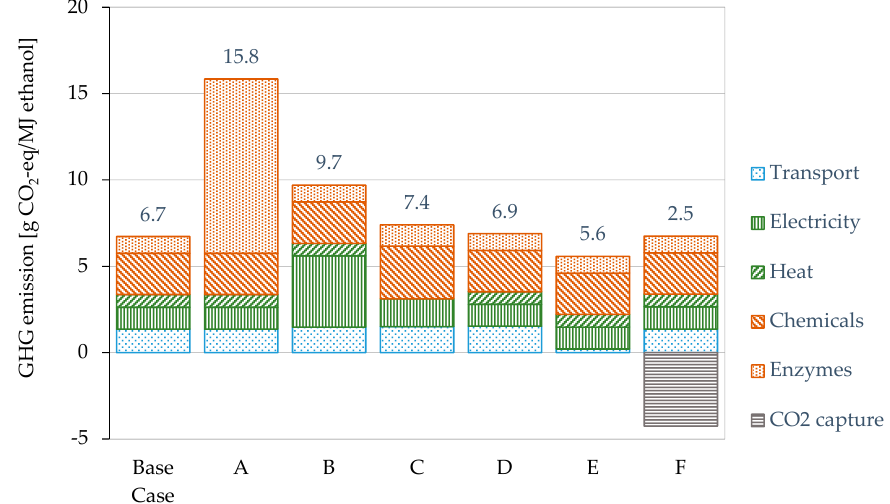
Figure 2. GHG emissions [g CO 2 ‐ eq /MJ Ethanol] for the different alternatives. Net values shown above bars.